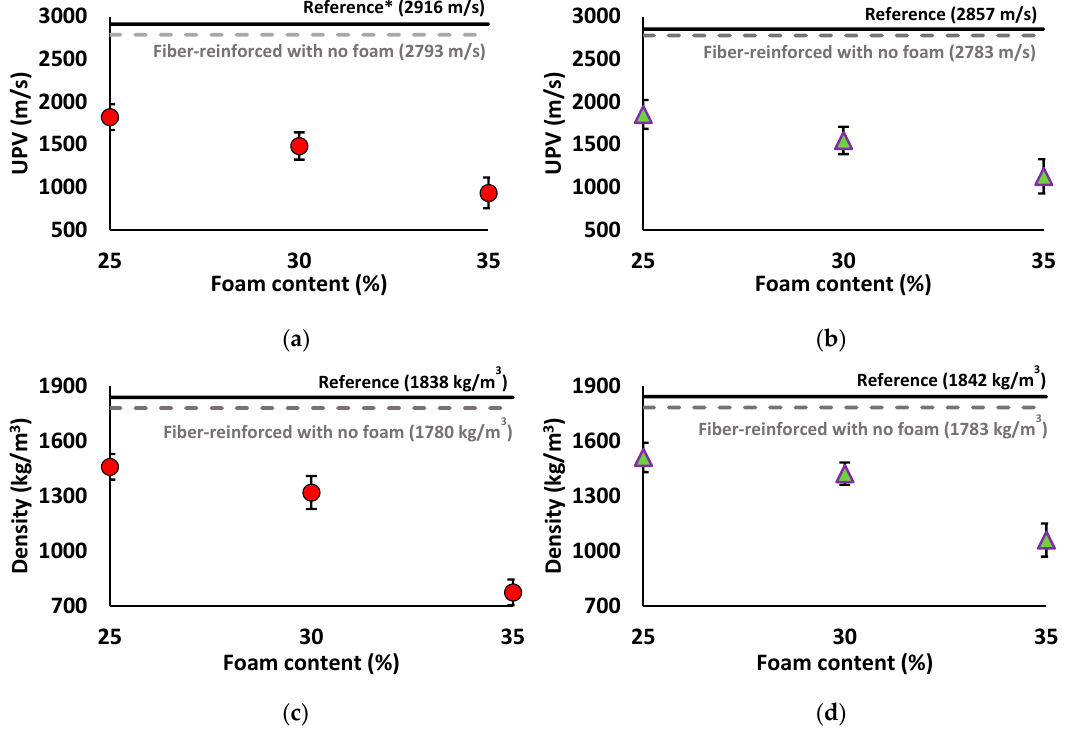
Figure6. ImpactsofaddingPPfibersanddi ff erentfoamcontentsontheUPVresultsofmixcompositions: Figure 6. Impacts of adding PP fibers and different foam contents on the UPV results of mix ( a ) SW50 / GW10; ( b ) SW30 / GW30; and density of mix compositions: ( c ) SW50 / GW10; ( d ) SW30 / GW30. compositions: ( a ) SW50/GW10; ( b ) SW30/GW30; and density of mix compositions: ( c ) SW50/GW10; (* plain mix composition with no foam and fiber ( d ) SW30/GW30. (* plain mix composition with no foam and fiber addition).